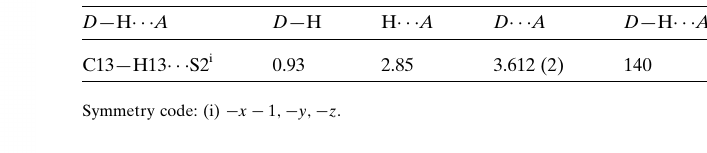
Table 2 Experimental details.